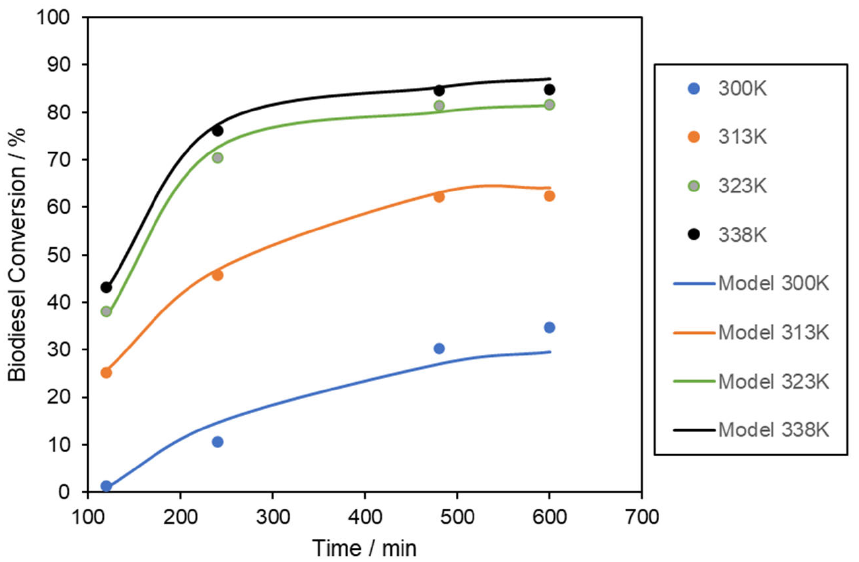
Figure 6. Temperature and reaction time effect on biodiesel conversion at a constant methanol-to-oil ratio of 5.33, using oil derived from Spirulina platensis microalgae. Experimental data were taken from